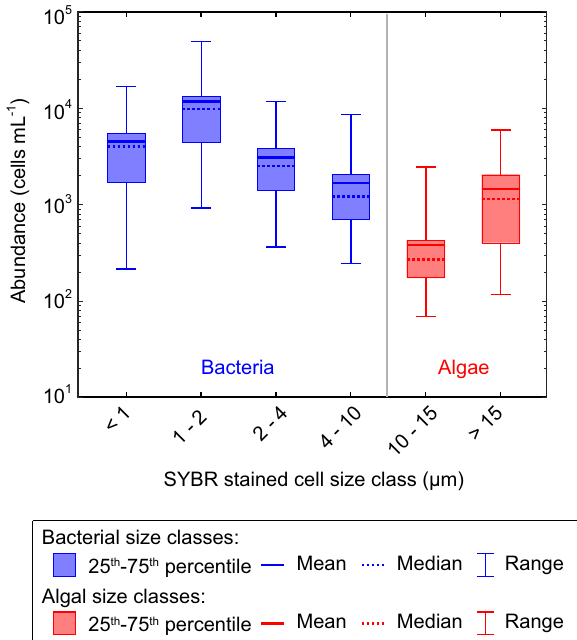
Fig. 4 Microbial abundance in weathering crust water samples according to cell size. Microbial size fractions and summary statistics for n = 73 independent meltwater samples drawn from the saturated zone within the weathering crust; the nominal classes of bacteria and algae are shown in blue and red, respectively. Samples with total microbial abundance >10 5 cells mL − 1 were excluded ( n = 10).